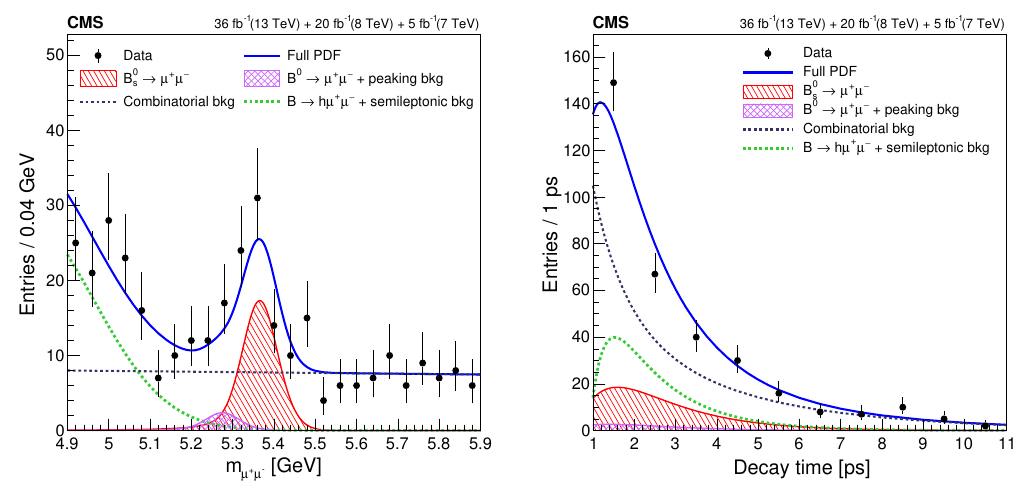
Figure 7 . Invariant mass (left) and proper decay time (right) distributions, with the 2D UML (cid:12)t projections overlaid. The data combine all channels passing the analysis BDT discriminator requirements as given in table 4. The total (cid:12)t is shown by the solid line and the di(cid:11)erent background components by the broken lines and cross-hatched distributions. The signal component is shown by the single-hatched